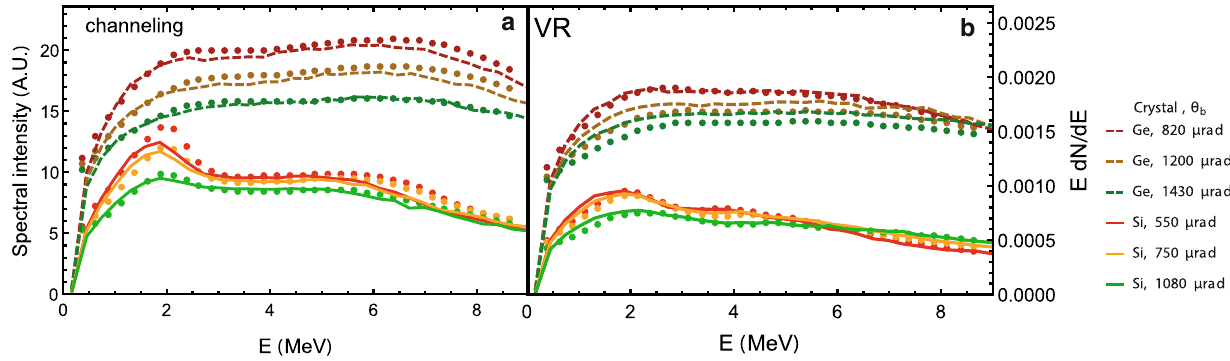
Fig. 5 Experimental (lines) and simulated (points) radiation spectral intensities for channeling ( a ) and volume reflection ( b ) alignments for bothSiandGebentcrystalswithdifferentvaluesofbendingangles.The